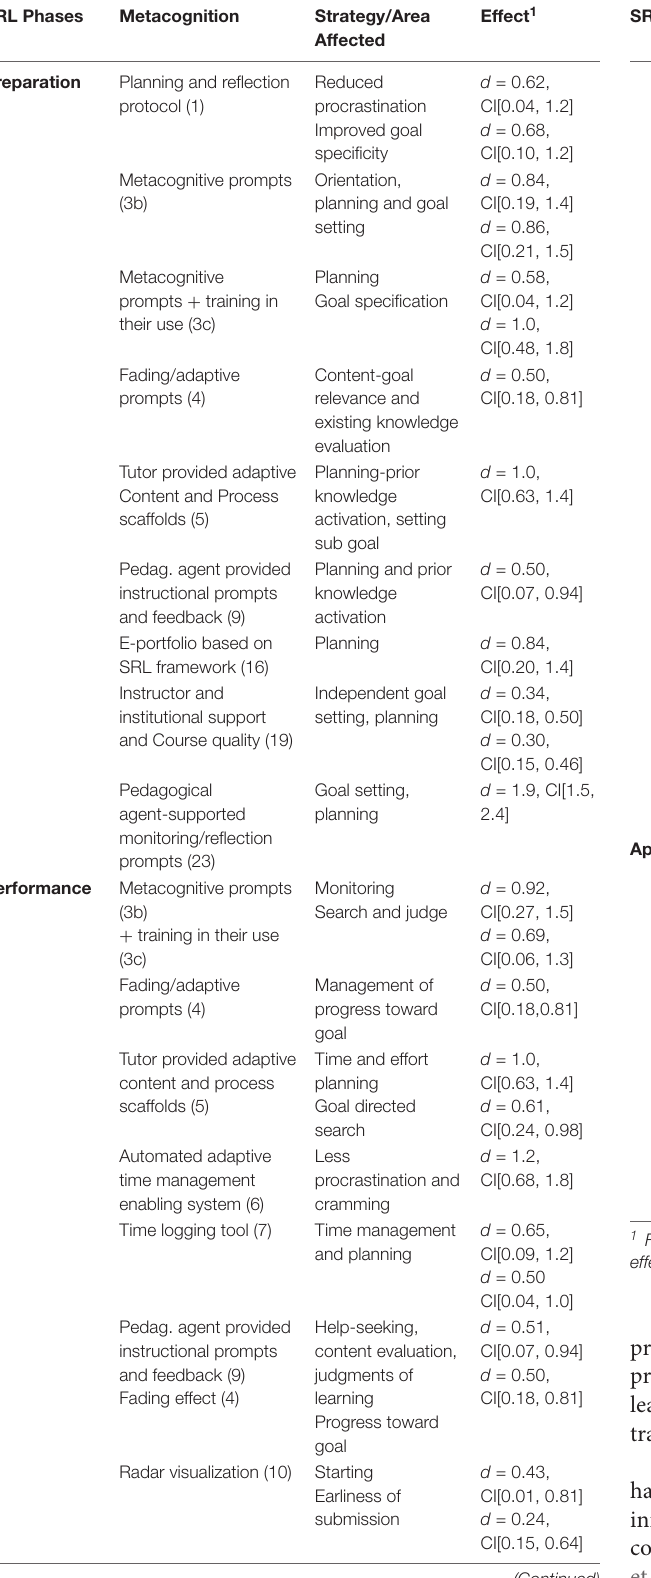
TABLE 4 | Metacognition regulation support interventions and areas